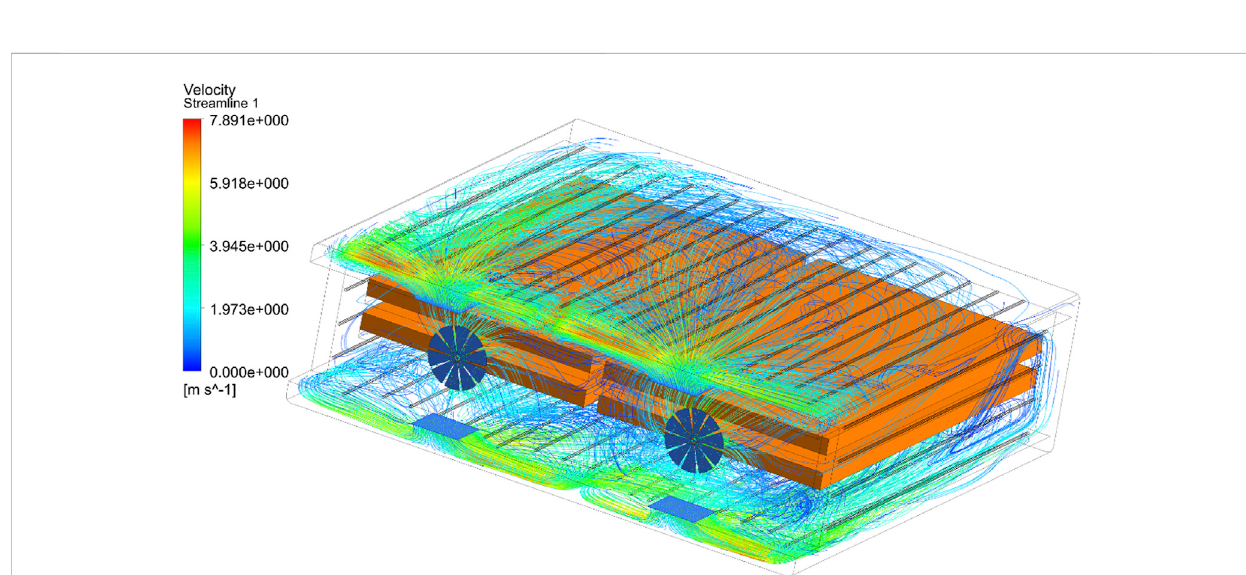
FIGURE 5 Instantaneous air fl ow velocity streamlines of the model at a simulation time of 2,400